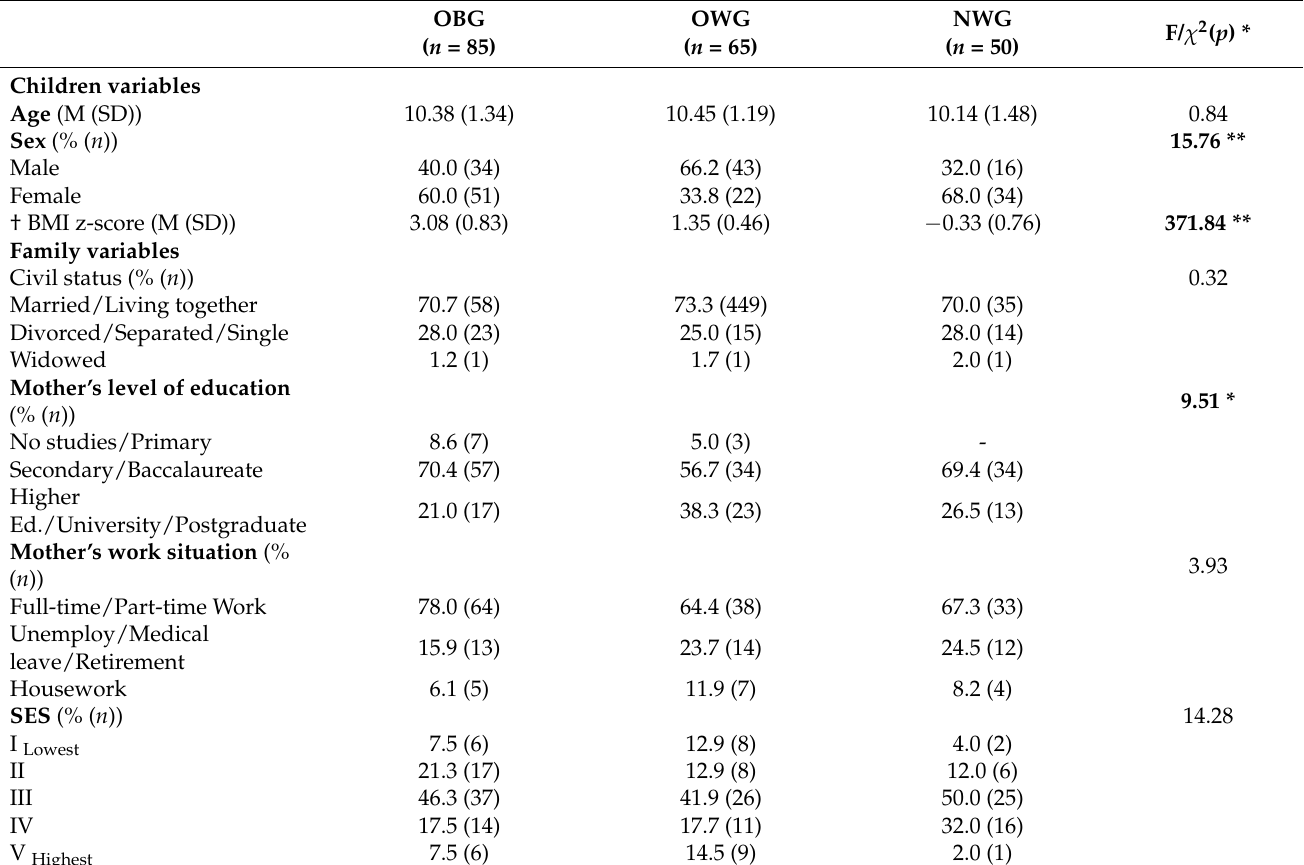
Table 1. Descriptive characteristics of children and their families. Comparisons by